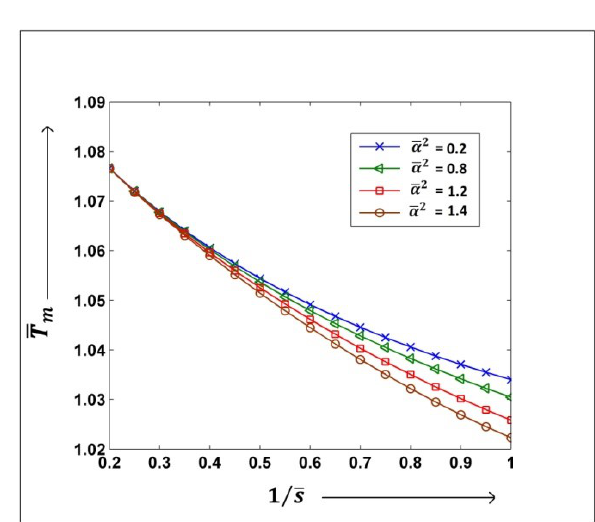
Fig. 8: Mean temperature vs. Slip parameter for different values of the material parameter at ¯ β = 1.3, ¯ γ 2 = 1.2, P . E = 1.2, ¯ x = r